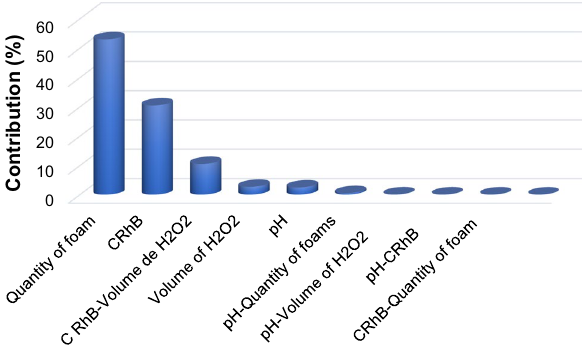
Fig. 4 Graphical Pareto analysis of effect of pH, concentration of RhB, volume of H 2 O 2 and number of foam samples on the discolora- tion efficiency